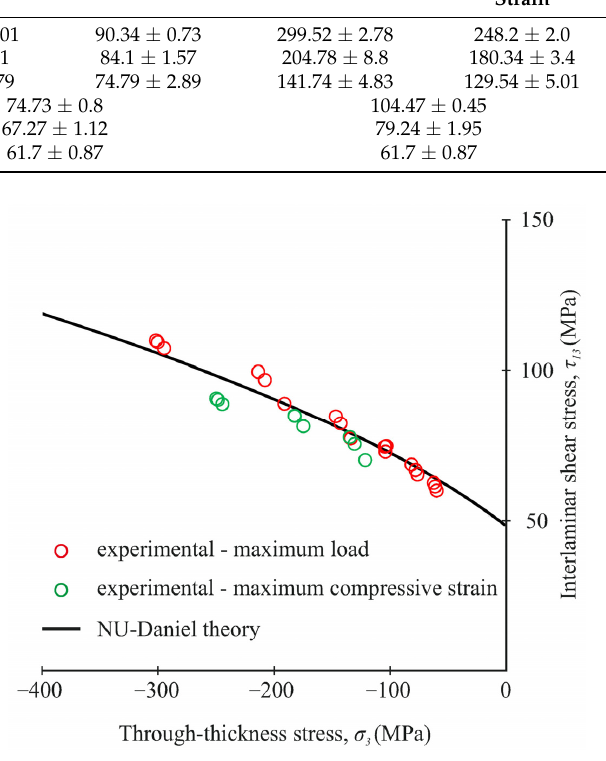
Figure 17. Comparison of the interlaminar shear strength, assessing with the maximum load and the maximum compressive strain with NU-Daniel theory. Table 3. Experimental assessment of stresses using two methods under biaxial loading. Interlaminar Angle